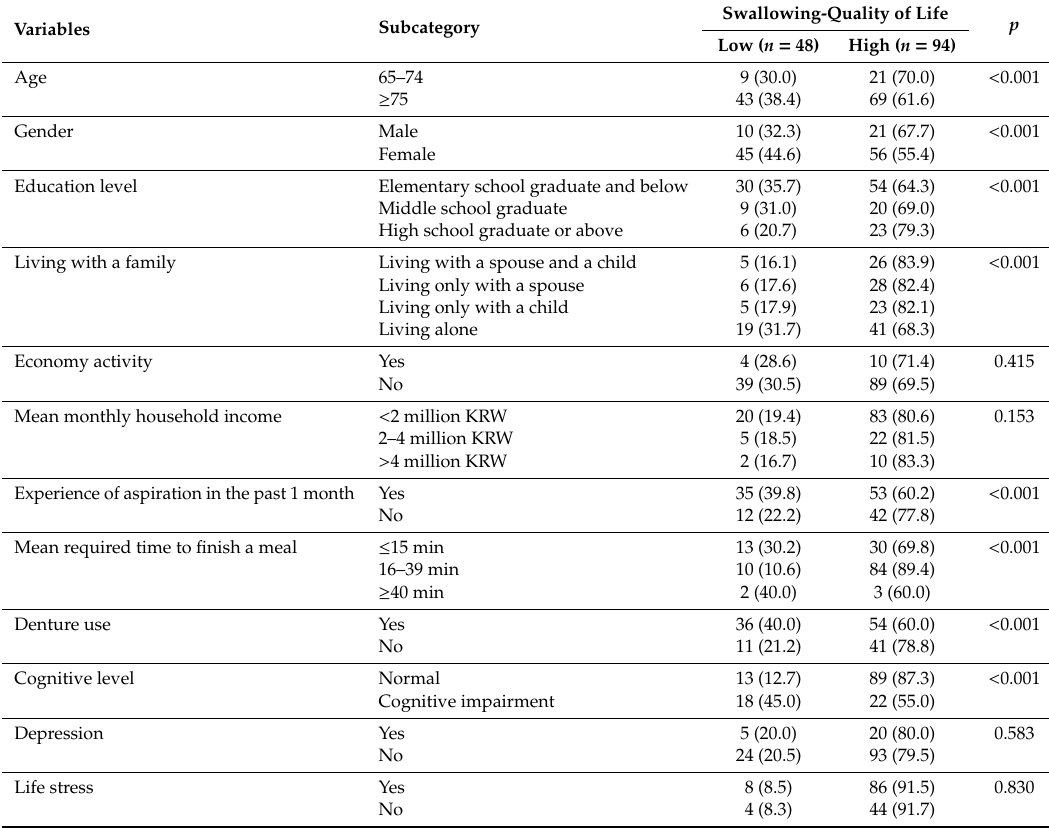
Table 2. The factors potentially related to the swallowing quality-of-life,